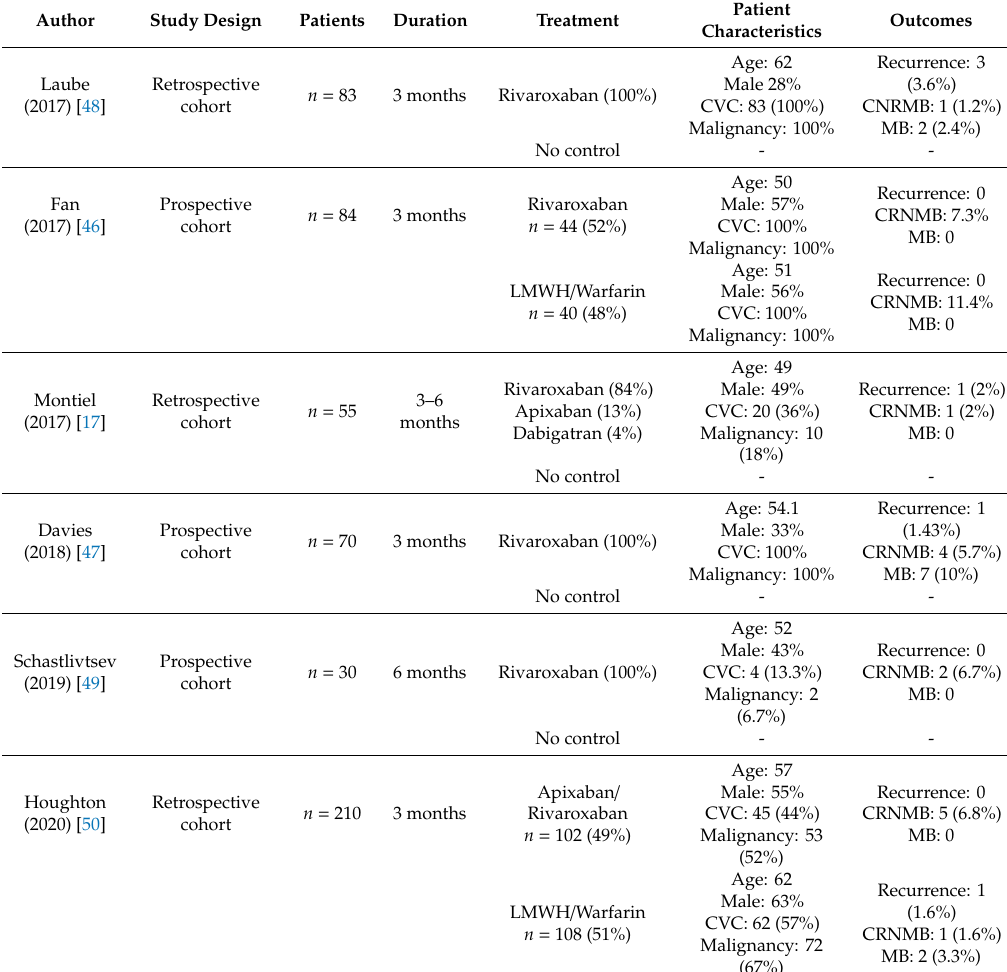
Table 2. Direct oral anticoagulants for the treatment of upper extremity deep vein